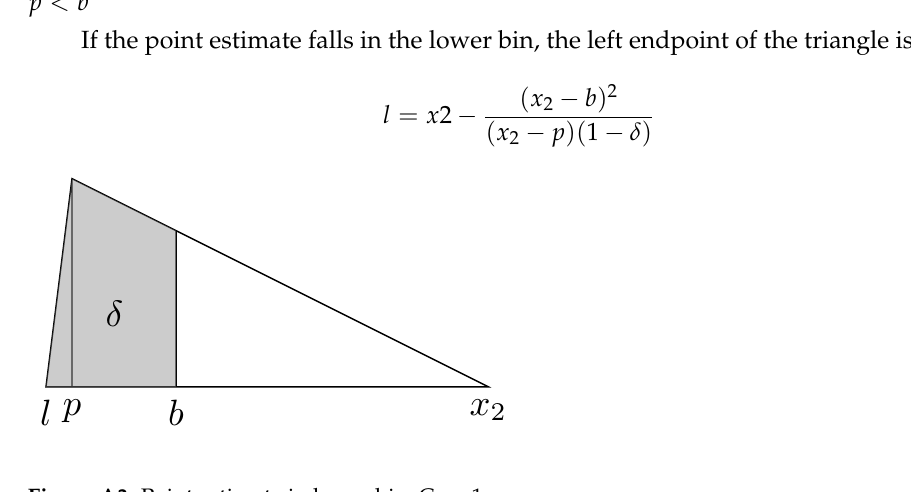
Figure A3. Point estimate in lower bin, Case 1.